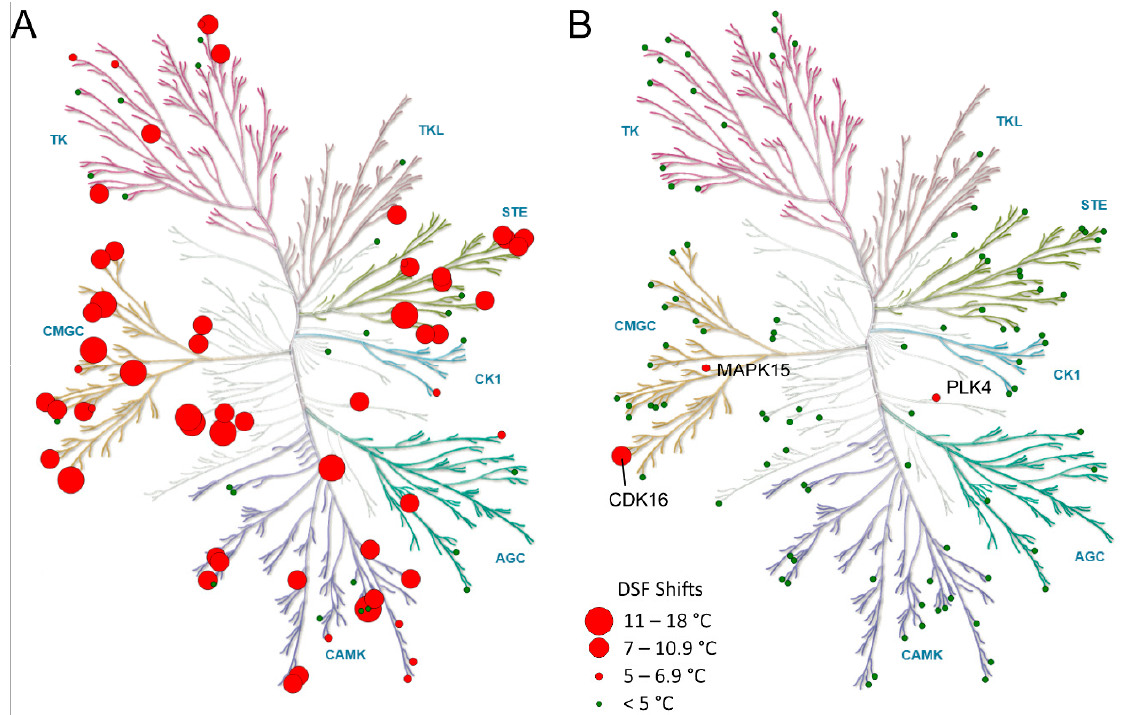
Figure 5. ( A ). Graphic representation of the selectivity data of 1 preserved from the DSF assay, illustrated with Cell Signaling Technology. ( B ). Graphic representation of the selectivity data of 43d preserved from the DSF assay, illustrated with Cell Signaling Technology.